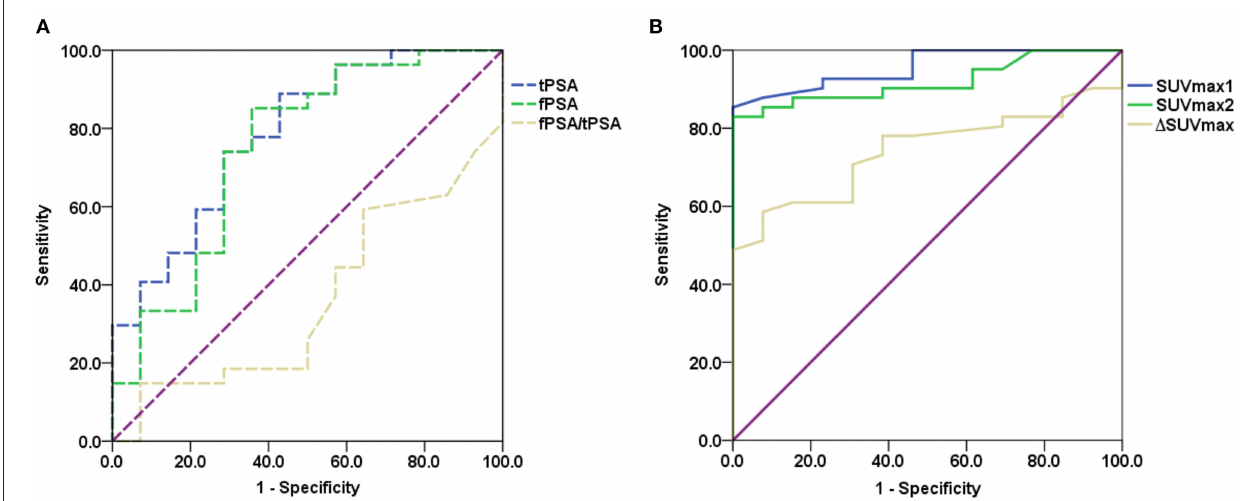
FIGURE 4 | ROC curves evaluating diagnostic performance of PSA levels (A) and 68 Ga-PSMA SUVmax (B) .